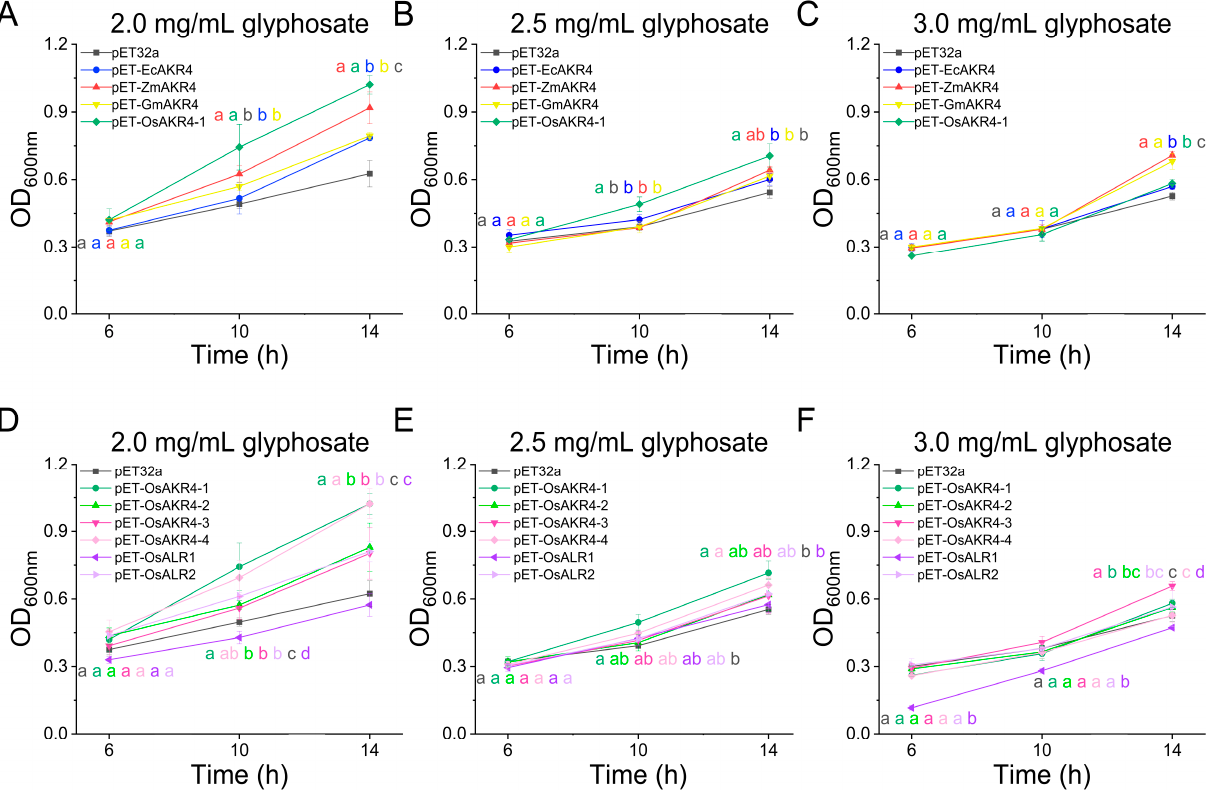
Figure 2. Growth of Escherichia coli BL21 expressing pET32a empty vector and pET32a-AKR in the presence of glyphosate. ( A – C ) E. coli growth curves plotted at OD 600nm influenced by EcAKR4 , ZmAKR4 , GmAKR4 and OsAKR4-1 . The cells were grown in a liquid medium containing 2.0 mg/mL ( A ), 2.5 mg/mL ( B ) or 3.0 mg/mL ( C ), of glyphosate. ( D – F ) E. coli growth curves plotted at OD 600nm influenced by AKRs from rice ( OsAKR4-1 , OsAKR4-2 , OsAKR4-3 , OsAKR4-4 , OsALR1 and OsALR2 ). The cells were grown in a liquid medium containing 2.0 mg/mL ( D ), 2.5 mg/mL ( E ), or 3.0 mg/mL ( F ), of glyphosate. Data are mean ± standard deviation. n = 3. ( p < 0.05; Duncan’s multiple range tests).